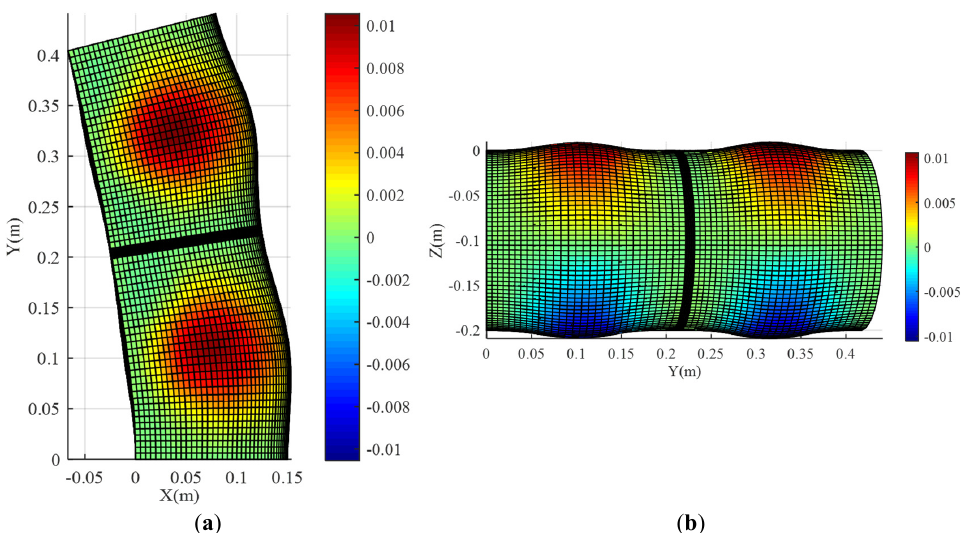
Figure 16. The deformation of two chambers under the pressure of 12 kPa . ( a ) Front view, ( b ) right view.